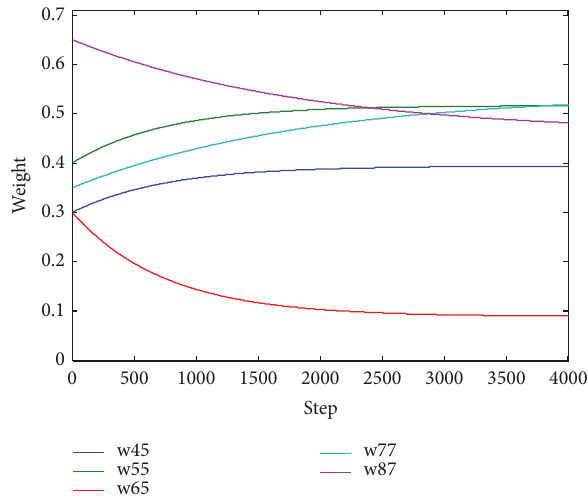
Figure 4: Weighing adjustment curve.